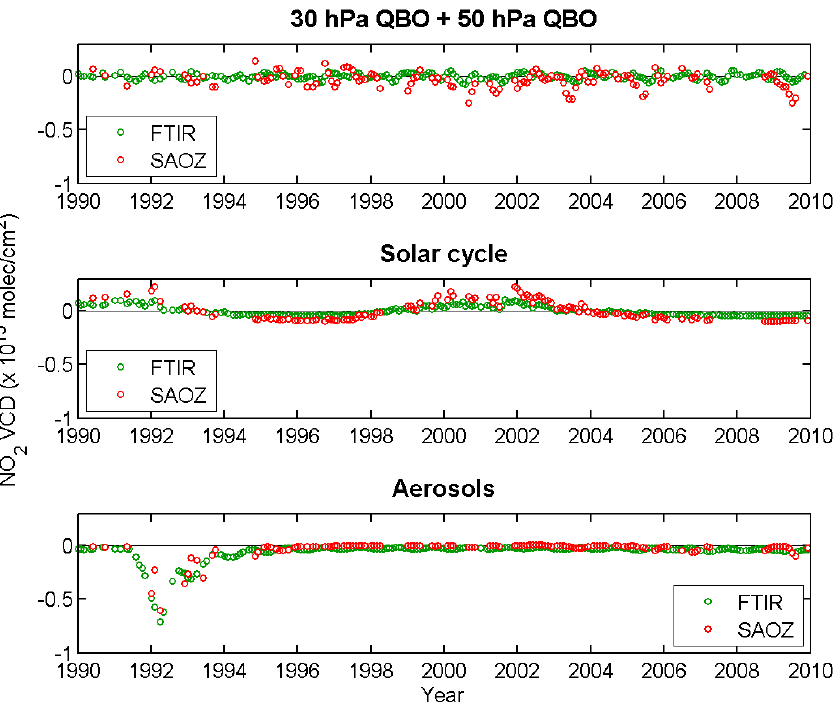
Fig. 5. Contributions of the QBO (upper plot), solar cycle (middle plot), and aerosols (lower plot) basis functions to the FTIR and SAOZ signals.